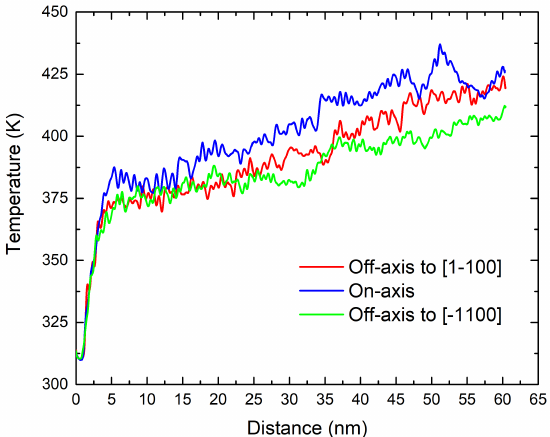
Figure 7. Workpiece temperature of the cutting with different lattice